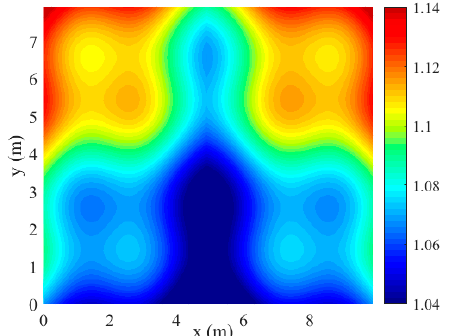
Figure 5. Bottom elevation of a 2D test with several storage